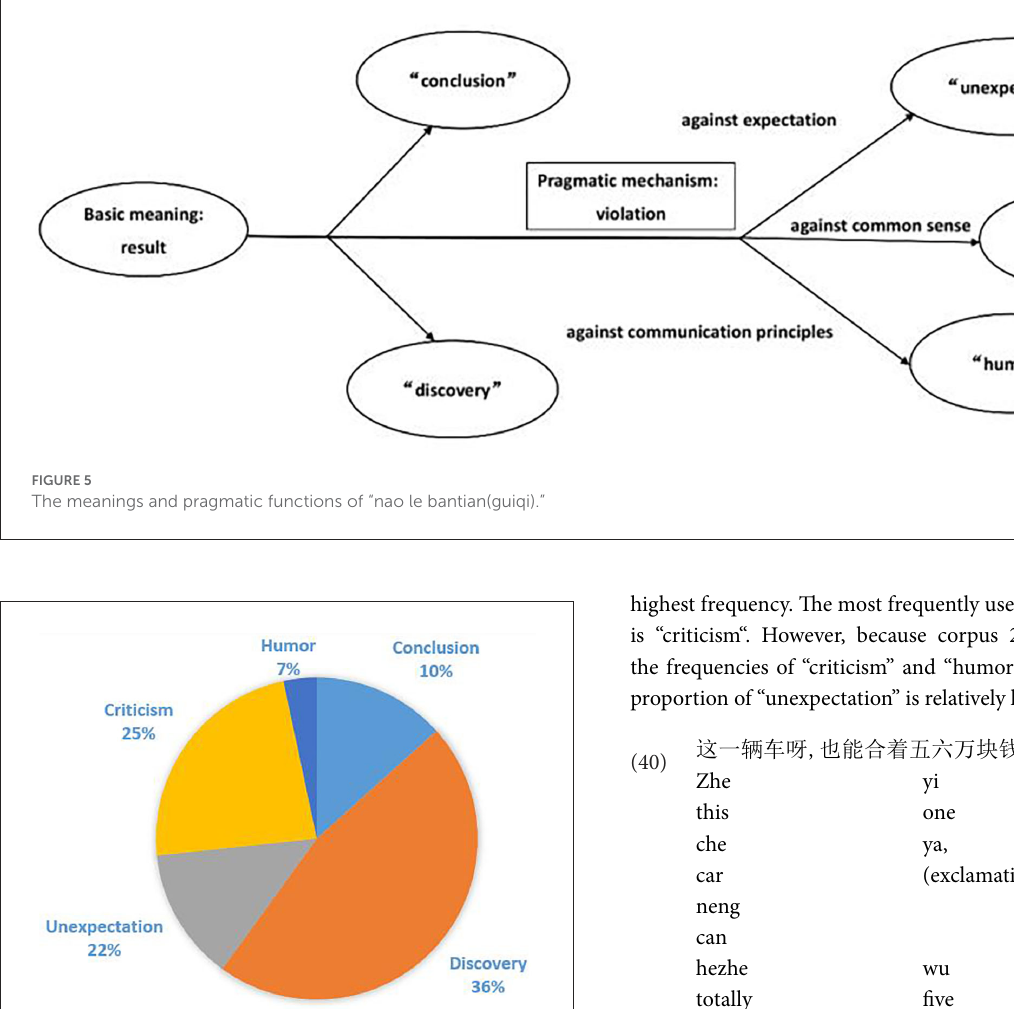
FIGURE6 Distribution of “nao le